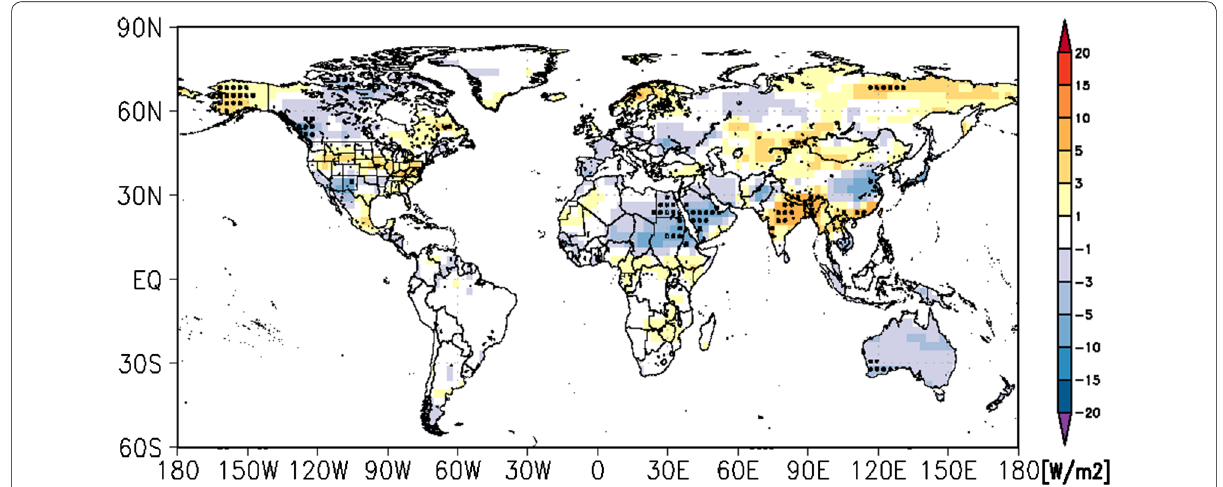
Fig. 7 Same as in Fig. 6 but for OLR outgoing longwave